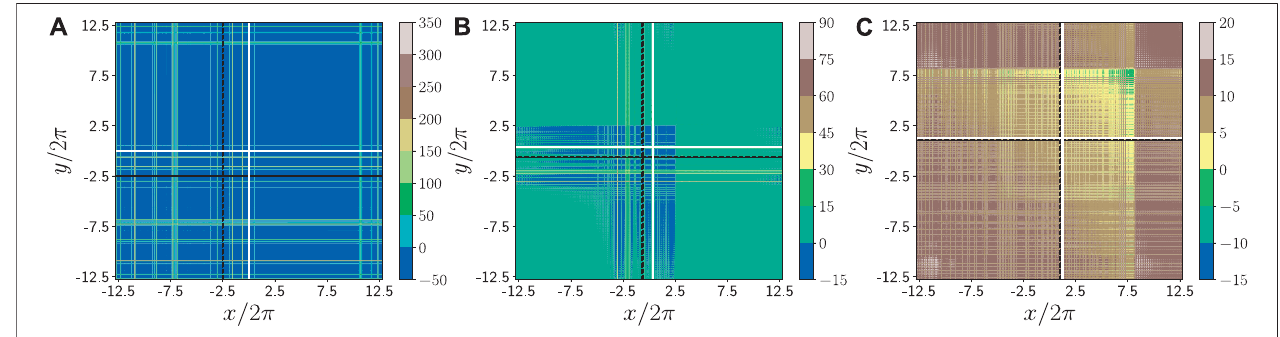
(cid:10)(cid:10) √ (cid:4)(cid:4)(cid:4)(cid:4) (cid:4)(cid:4)(cid:4)(cid:4) ) ∇ Ψ ( x , y , ξ − / 2 Sforthreedifferentpropagationdistances:a, ξ 0 (cid:2) 0.176;b, ξ 0 (cid:2) 7.5;andc, ξ 0 (cid:2) 0